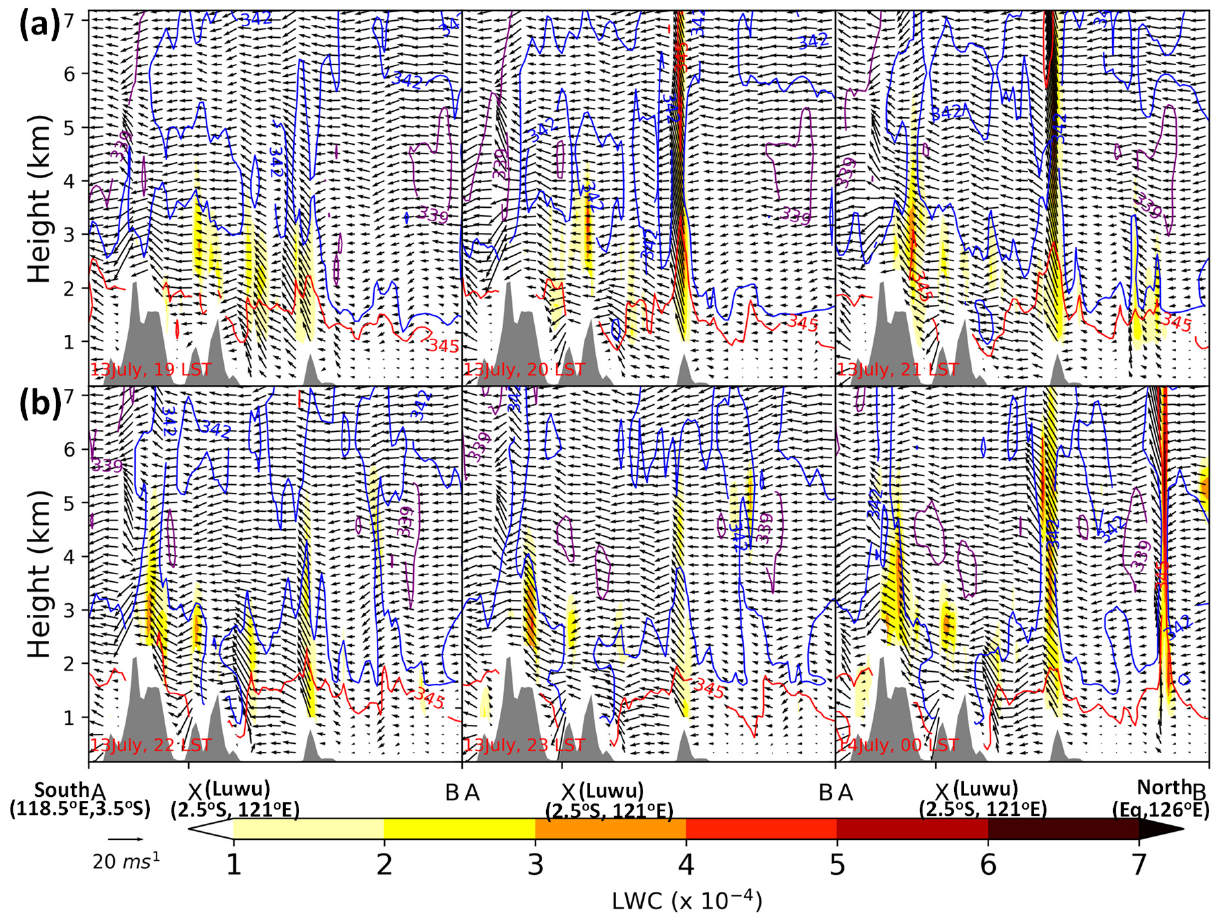
Figure 8. Height–latitude cross-sections of wind (vectors; vertical component multiplied by a factor of 40), cloud mixing ratio (shading), and equivalent potential temperature anomaly (contours) on 13 July 2020 for ( a ) 19:00–21:00 LST and ( b ) 22:00–00:00 LST. The ‘X’ indicates the location of Luwu. For clarity, the equivalent potential temperature has had 343 K subtracted from it, with blue (red) lines indicating negative (positive) values. The contour interval is 1.5 K. The A-B transect refer to point locations in Figure 4b.